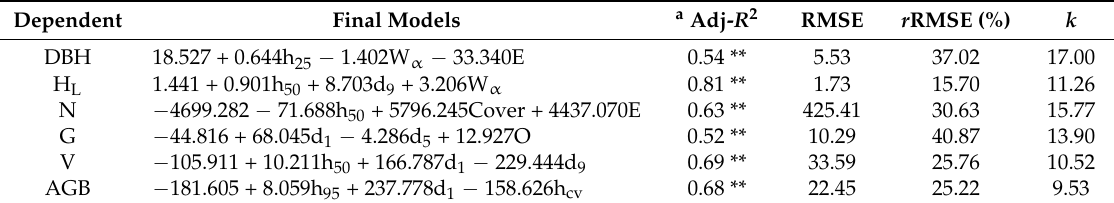
Table 5. Summary of the forest structural parameters prediction models with point cloud data based metrics and plot-level accuracy assessment results.